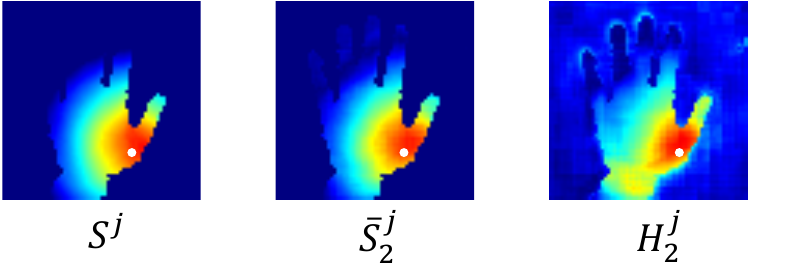
Figure 5. Qualitative results of the heatmaps of the MCP joint center of the thumb. The white dot represents the center of the MCP joint of the thumb. Warm-colored areas are considered more spatially correlated with the MCP joint than cold-colored areas. Compared to the spatial closeness heatmap, the fused heatmap finds more spatially correlated points on the wrist.